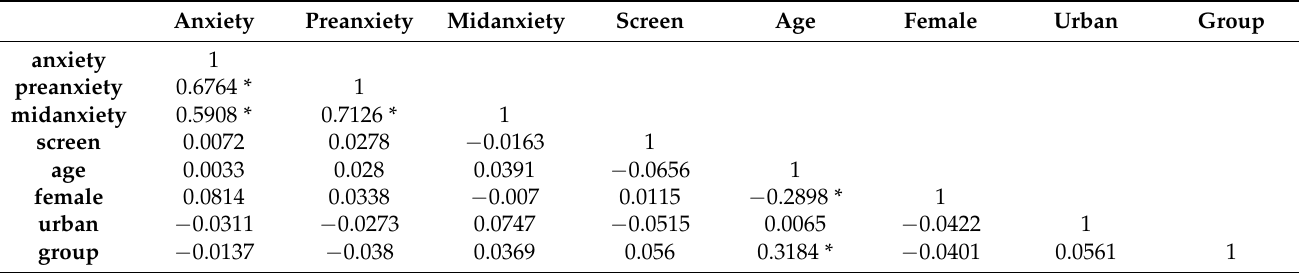
Table A1. Spearman correlation matrix (recreation screen time as an ordinal variable).